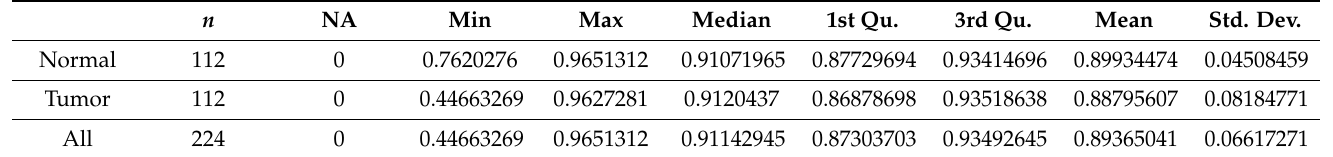
Table 1. Bladder β -values and